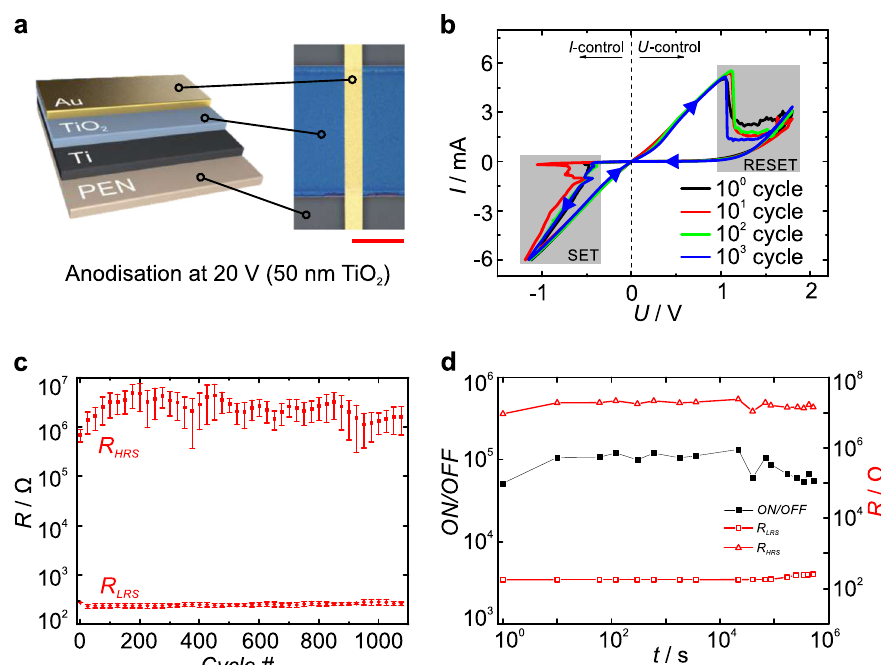
Fig. 4 Titanium oxide memristors. a Schematic illustration of the memristor devices with 50 nm titanium oxide layer together with an optical microscope picture. Scale bar: 300 μ m. b Current – voltage characteristic of a typical memristor for one (black trace), 10 (red trace), 100 (green trace), and 1000 (blue trace) switching cycles. No signi fi cant changes in switching hysteresis are observed. The SET and RESET half-cycles are performed under current control and voltage control, respectively, to reduce power dissipation and improve lifetime. c HRS (high resistive state, R OFF ) and LRS (low resistive state, R ON ) for over 1100 switching cycles, showing no visible degradation. d Long time retention measurements for 6 days (533,060 s). Readout of both LRS and HRS is reliable without visible degradation, ultimately implying that stable memory performance is